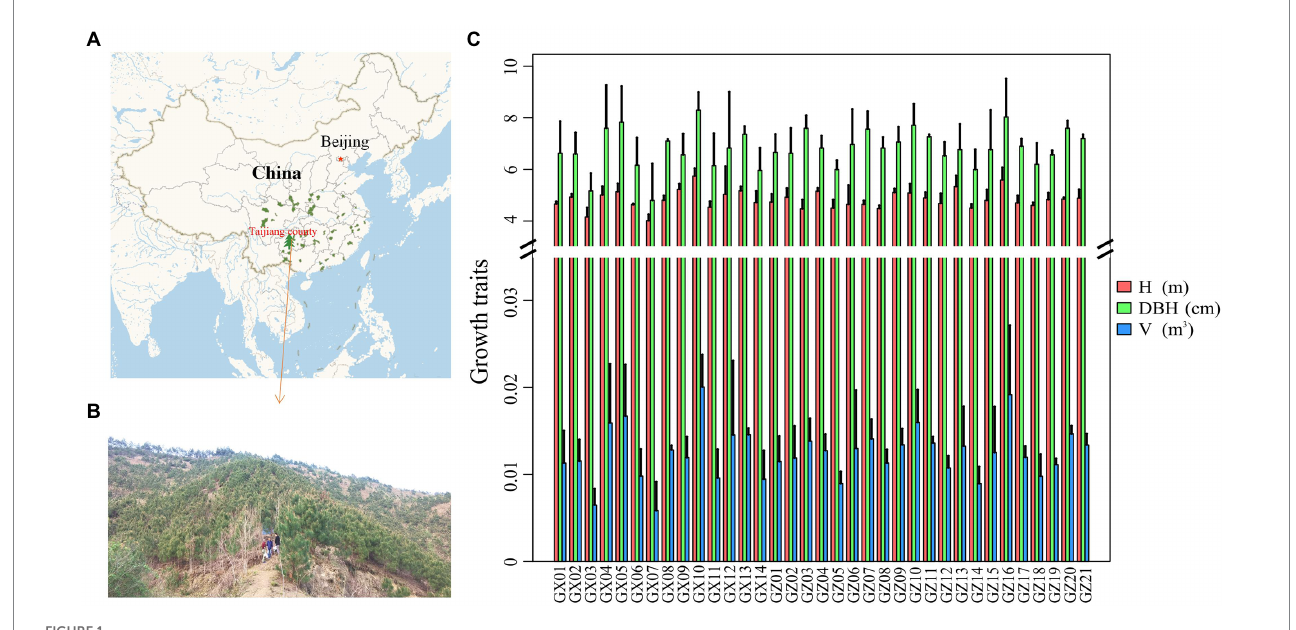
FIGURE 1 Distribution of Masson pine resources (A) , study area and plot setting (B) , and growth status (C)